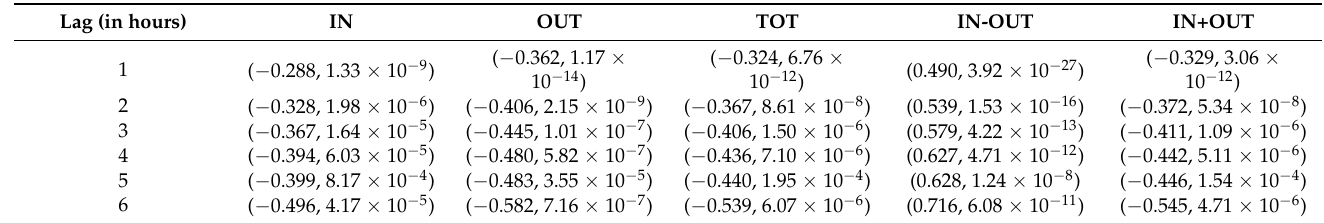
Table 7. Pearson coefficients and corresponding p -values of different types of traffic measurements and different lags for hive H17; each cell is a tuple ( c , p ) where c is Pearson and p is p -value; IN—incoming traffic; OUT—outgoing; TOT—total.